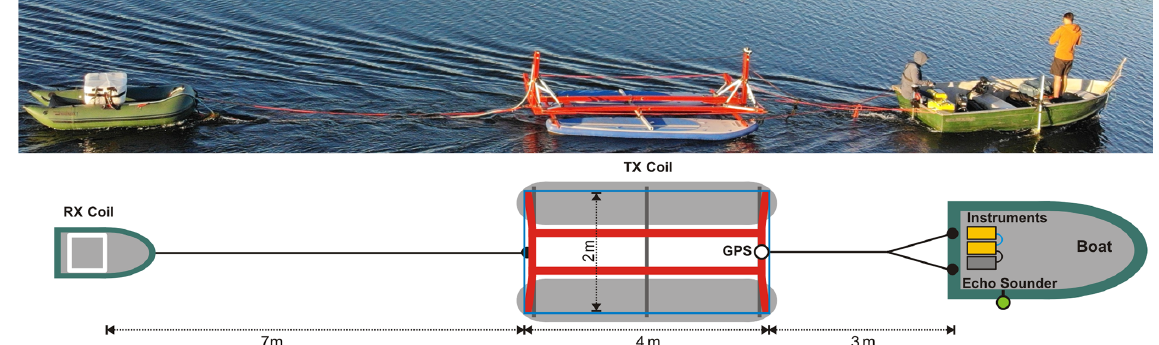
Figure 1. Picture and schematic of the freshwater FloaTEM configuration, with boat, transmitter coil (TX coil), and receiver coil (RX coil). In contrast, the saltwater configuration uses a 4m × 4m transmitter